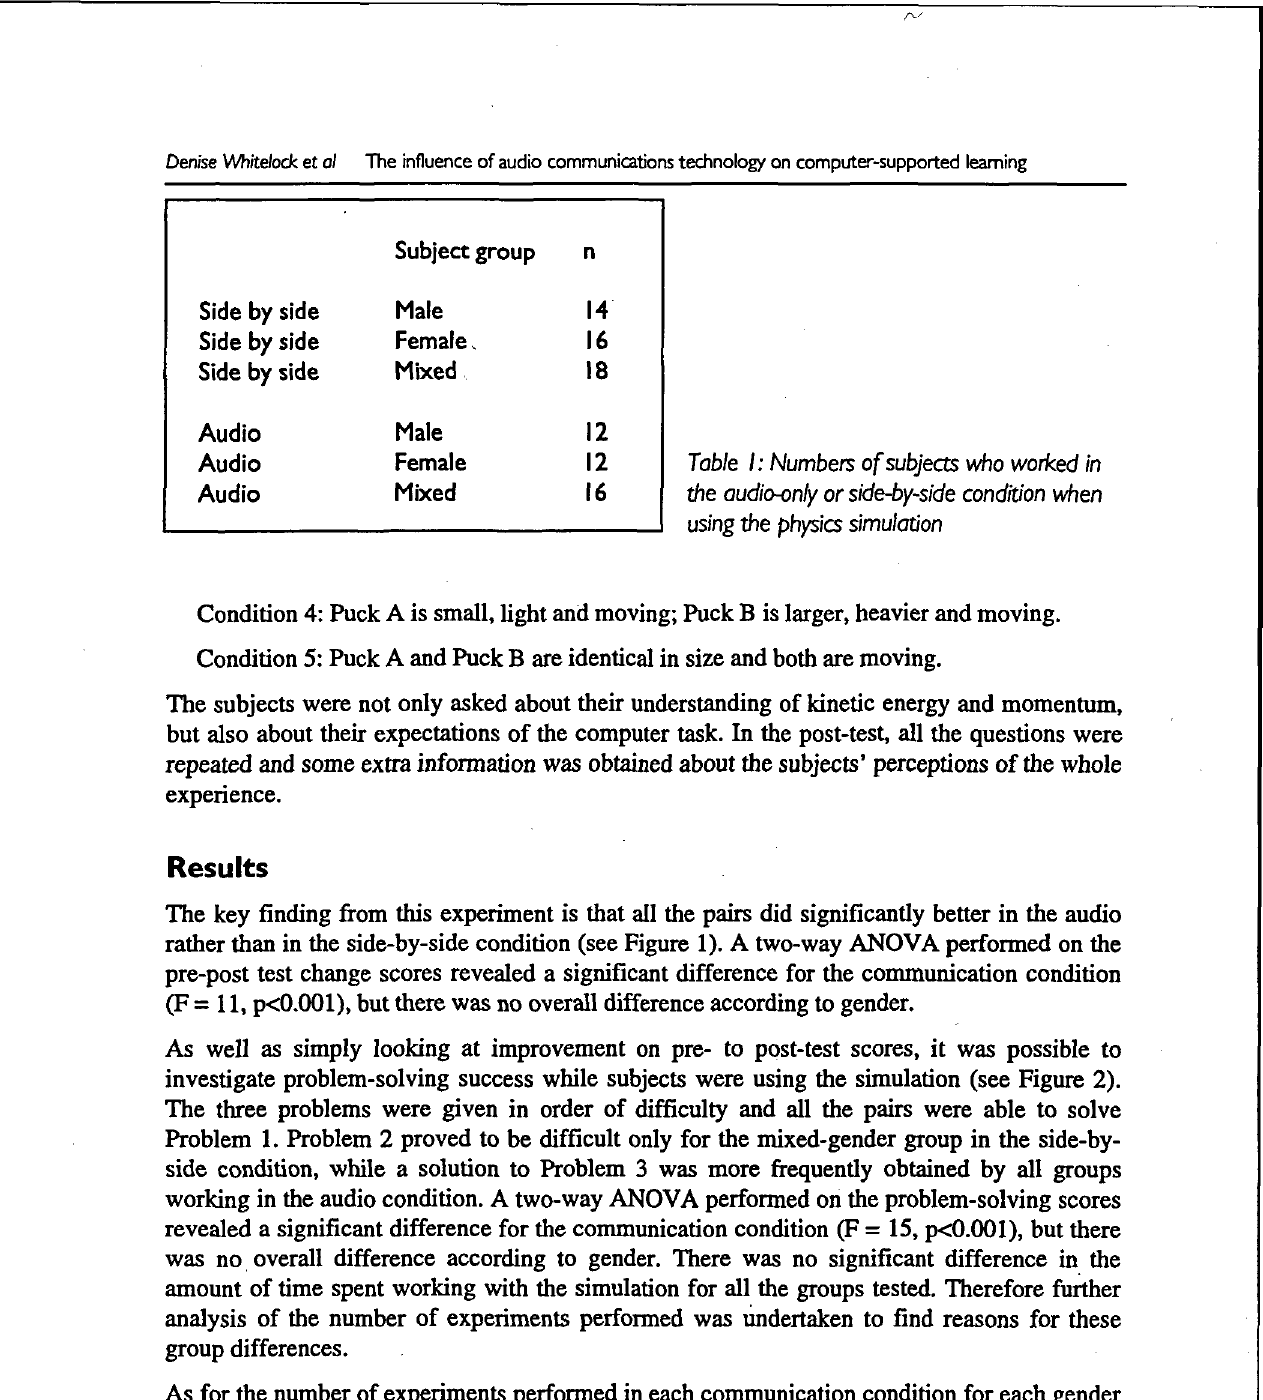
Table I: Numbers of subjects who worked in the audio-only or side-by-side condition when using the physics